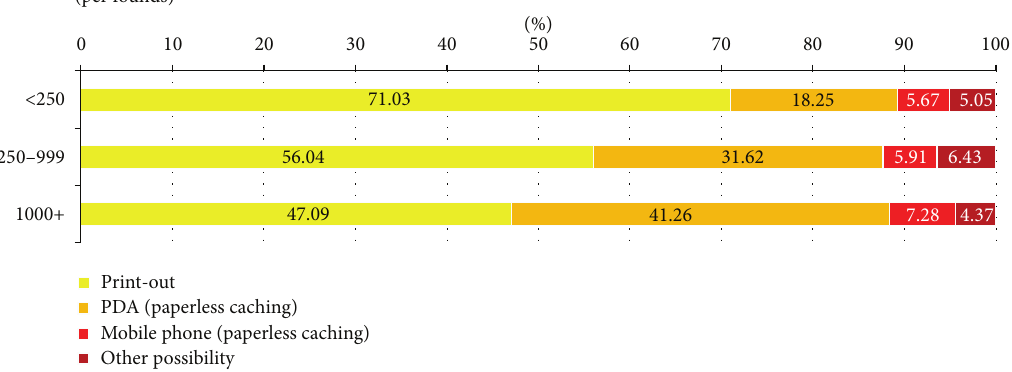
Figure 4: Ways of carrying around the cache